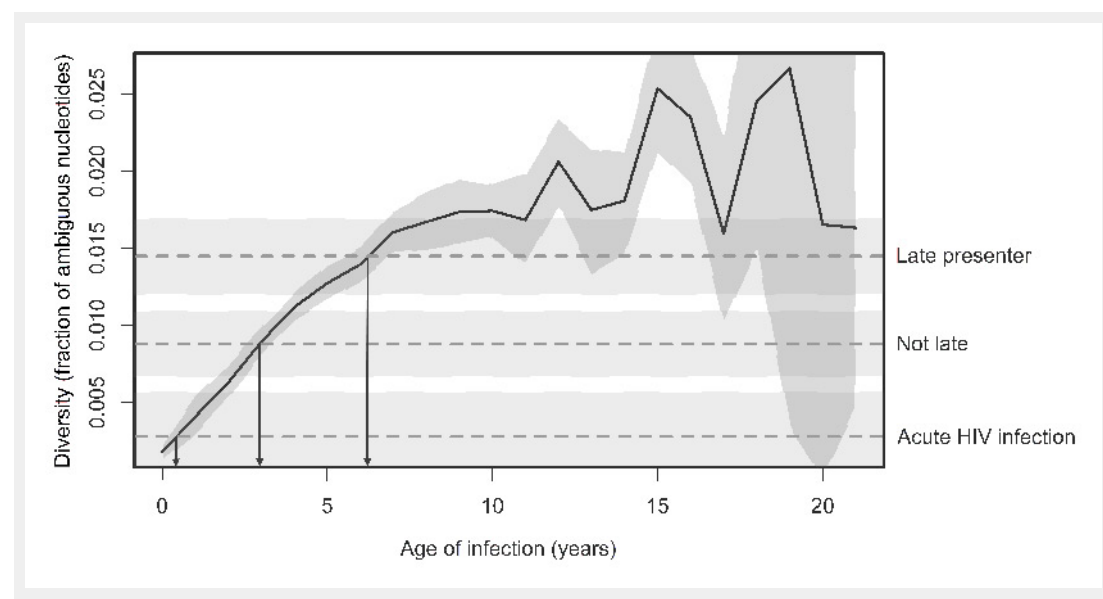
Figure 2 Relationship between the year of infection and the fraction of ambiguous nucleotides. The solid black line represents the mean fraction as a function of the age of infection, where data points have been binned according to the age of infection in years (n = 3,307 patients). (Figure adapted from [18] Roger D. Kouyos et al.: Ambiguous Nucleotide Calls From Population-based Sequencing of HIV-1 are a Marker for Viral Diversity and the Age of Infection, Clinical Infectious Diseases, 2011, 52(4):532–539, by permission of Oxford University Press.) The dashed horizontal lines depict the mean fraction from the three groups of our study and the shaded area represents the 95% confidence intervals. The three arrows from the intersections of the curve with the horizontal lines point to estimated durations of HIV infection of approximately 6, 3, and <1 years for the three groups. HIV = human immunodeficiency